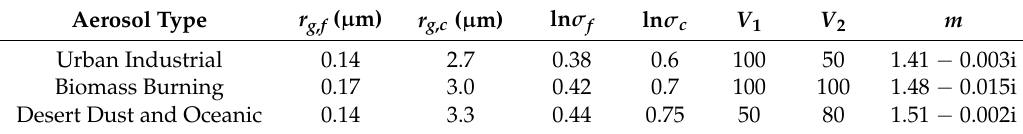
Table 1. Simulated parameters of bimodal lognormal